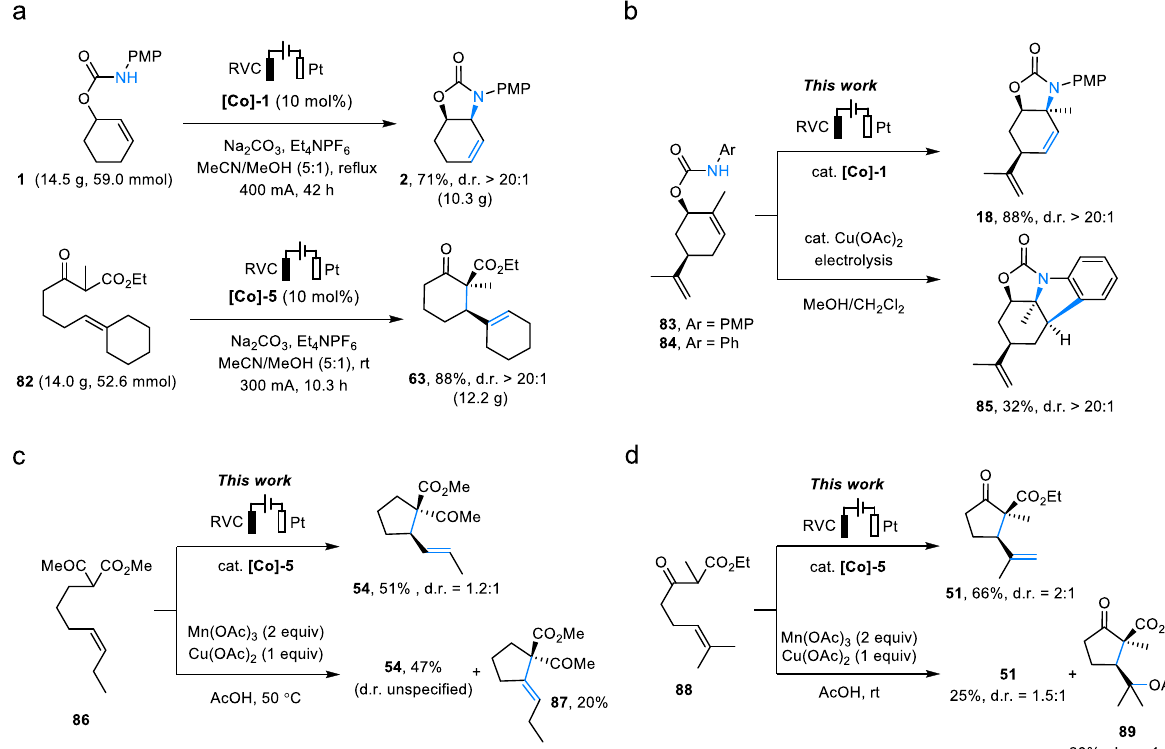
Fig. 4 Decagram scale synthesis and comparison of Co-catalyzed versus Cu-based allylic C – H functionalizations. a Decagram scale synthesis of 2 and 63 . b Comparison of the reaction patterns of Co- versus Cu-catalyzed cyclization of sterically hindered alkenes. c , d Comparison of selectivities of Co- catalyzed versus Mn/Cu-mediated allylic C – H alkylation of di- and trisubstituted